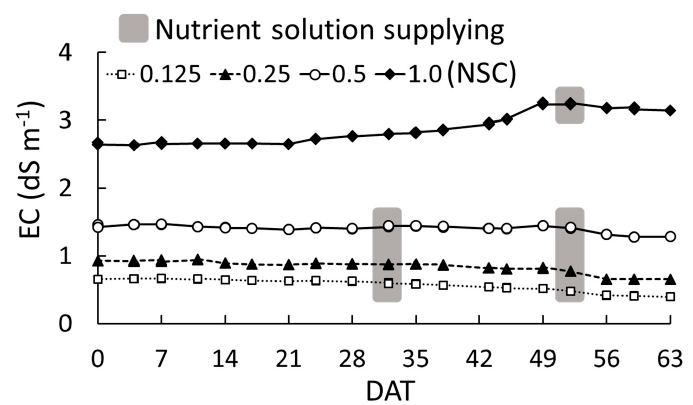
Figure 1. Change in electrical conductivity (EC) in each nutrient solution concentration (NSC) for 63 days after the start of the treatment (DAT) in experiment 1. The treatments were 0.125, 0.25, 0.5, and 1.0 NSC. The 1.0 NSC was the standard concentration of Otsuka-A nutrient solution. The grey marked DATs indicate the timing of the supply of the nutrient solution.